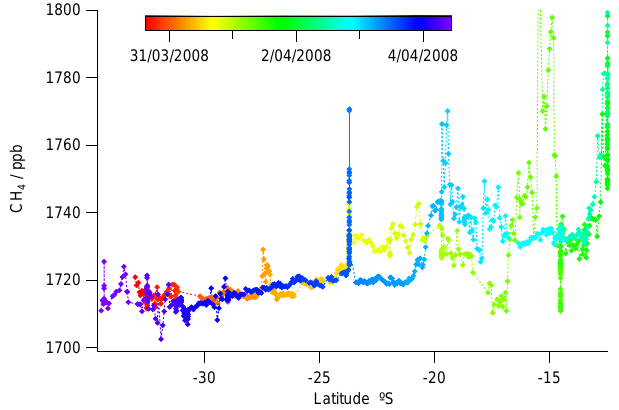
Fig. 9. Measurements of CH 4 along a N–S transect aboard the Ghan train from Adelaide (34 ◦ S) to Darwin (12 ◦ S), March–April 2008. Figure adapted from (Deutscher et al., 2010), see text for summary.